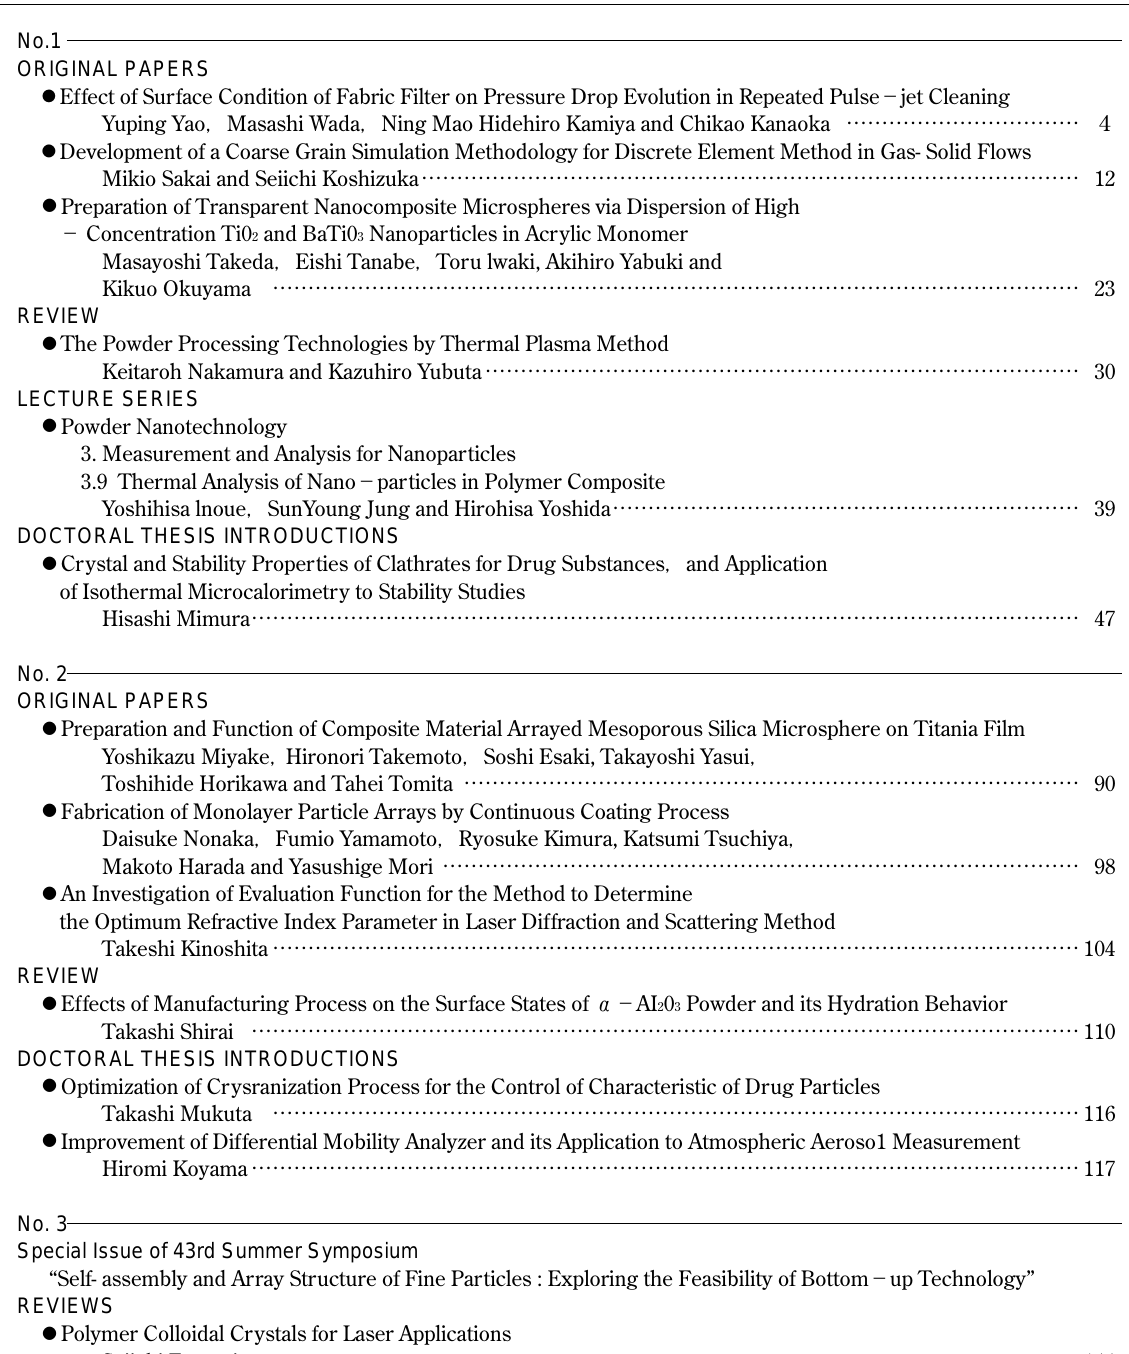
“Self- assembly and Array Structure of Fine Particles : Exploring the Feasibility of Bottom − up Technology” ● Polymer Colloidal Crystals for Laser Applications ● Determination of Critical Particle Concentration for Colloidal Crystallization with Sma11 Amount of Sample